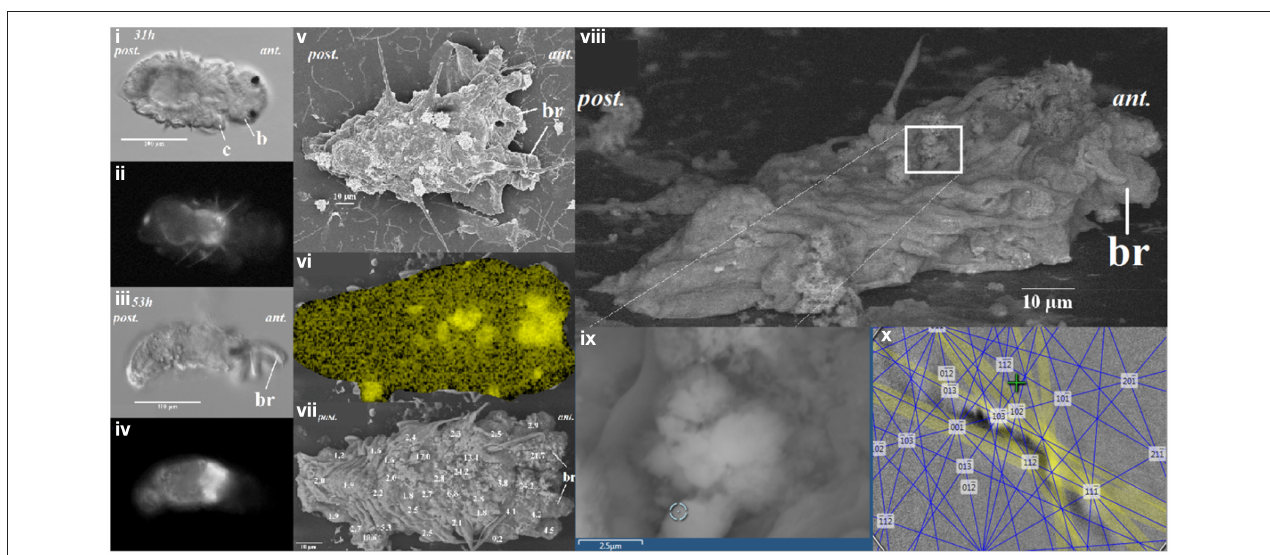
FIGURE 2 | The distribution of calcium ion as correlated to calcein signal at 31 and 53h after metamorphosis of the Hydroides elegans . The DIC images [left panel; (i,iii) ] and the calcein signal [left panel; (ii,iv) ] are shown. Correlative electron microscopy on the day 2 post-metamorphic Hydroides elegans detected spots of calcified structures, as shown in a lower-voltage (5 kV) SEM image [middle panel; (v) ]. SEM-EDS analysis mapping, performed at 20kV, shows a heterogeneous distribution of calcium [middle panel; (vi) , Ca; in yellow]. The Ca contents are presented as numbers overlaying a greater surface detail of lower-voltage (5kV) image of the tubeworm, the Ca contents (mol wt%, decimal points are aligned to show the location of spot analyses) obtained from spot quantification (with SEM-EDS at 20kV) [middle panel; (vii) ]. Regions with a Ca content higher than 15mol wt% are likely to be calcified structures. SEM-EBSD analysis of the calcium rich regions is illuastrated in the right panel of (viii–x) . The calcium rich regions (white box) as found in SEM-EDS results were further analyzed with EBSD [right panel; (viii) ]. (ii) The circle [right panel; (ix) ] indicates the EBSD analysis site; a Kikuchi pattern [right panel; (x) ] suggests the site is aragonitic from the interface of EDS/EBSD microanalysis software. c, collar; b, branchial lobes; ant, anteior; post,